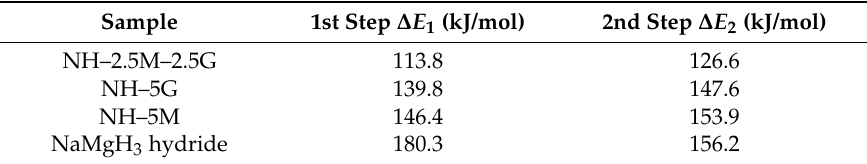
Figure 3. The relationship curves between ln( T p2 /υ) and (1000/ T p ) for NaMgH 3 hydride and composites fitted by Kissinger method. (A) NH–2.5M–2.5G; (B) NH–5G; (C) NH–5M; (D) NaMgH 3 hydride ( a ) for the first decomposition step of NaMgH 3 hydride and ( b ) for the second decomposition step of NaMgH 3 hydride. Table 1. Calculated value of Δ E of the decomposition of the NaMgH 3 hydride.